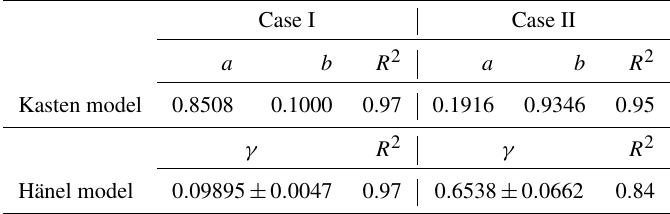
Figure 5. The vertical profiles of (a, g) water vapor mixing ratio ( W ), (b, h) potential temperature ( θ ), (c, i) relative humidity (RH) cal- culated from radiosonde data, (d, j) backscattering coefficient at 532nm ( β 532 ), (e, k) the Ångström exponent (AE, (532–1064nm)), and (f, l) depolarization ratio retrieved from Raman lidar data for Case I (a–f) and Case II (g–l) . Horizontal dashed lines show the upper and lower boundaries of the layer under analysis (1642.5–1905.0m for Case I and 1680.0–2130.0m for Case II). Horizontal error bars denote the uncertainty of each property. Table 3. The fitting parameters and R 2 of the fits for the Kasten and Hänel